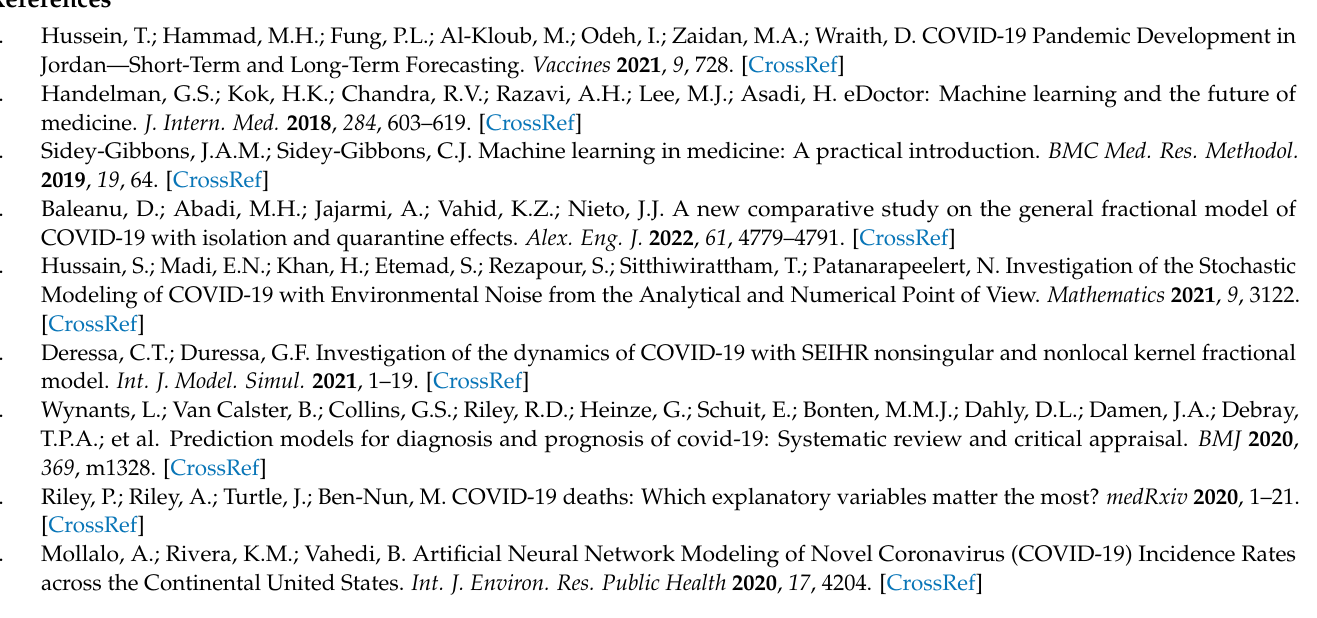
qPCR Tests. Figure S1. Scheme showing the short-term forecast (STF) model. This Figure was adopted from Hussein, et al. [1]. Figure S2. A scheme showing the long-term forecast (LTF) model. This Figure was adopted from Hussein, et al. [1]. Figure S3. A scheme showing the hybrid forecast (HF) model. This Figure was adopted from Hussein, et al. [1]. Section S2. Time Delay Neural Network (TDNN). FigureS4: The time-delay neural network (TDNN)